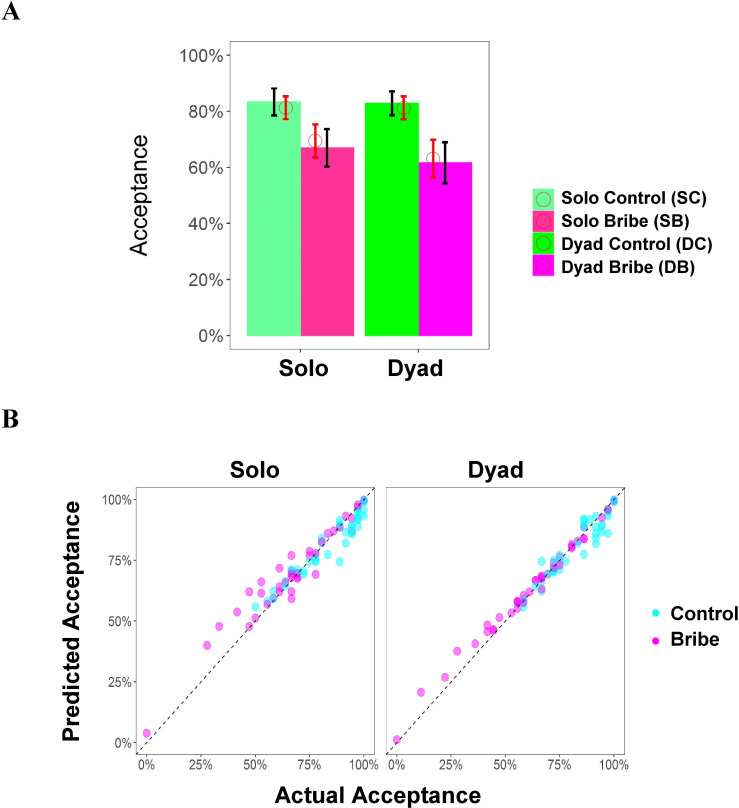
Posterior predictive check of the winning model.The model prediction (i.e., mean predicted proportion of acceptance) was calculated based on the posterior distribution of the parameters estimated based on the winning model in each experimental condition. (A) The bar plot of the average actual proportion of acceptance (%; indicated by the filled bar; the black bars indicate the SEM) and the average predicted proportion of acceptance (%; indicated by the red circle; red bars indicate 95% CI). (B) The scatter plot describing the actual proportion of acceptance (%) and the average predicted proportion of acceptance (%) across individuals. Each dot represents the data of a single participant.